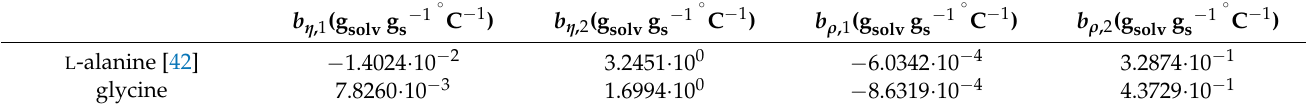
Table A1. Empirical viscosity and density coefficients for aqueous L -alanine or glycine solution.